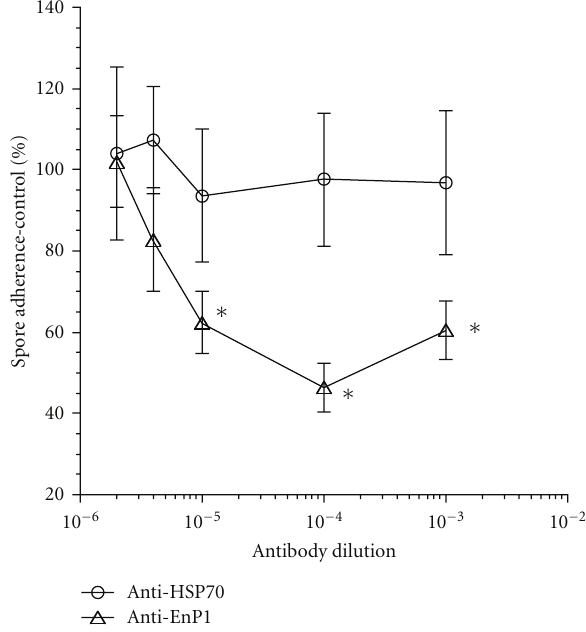
Figure 3: Purified antibodies specific for the internal C1 Hsp70 protein does not inhibit E. cuniculi spore adherence to rabbit kidney host cells. Increasing concentrations of C1 antibodies (open circles) or EnP1 specific antibodies (open triangle) were incubated with spores in the presence of confluent host cells. Control samples excluded antibodies. After 4-hours, unbound spores were removed by washing and the bound spores were quantified by immunofluorescence assay. Each antibody dilution sample was performed in triplicate. Statistical significance is indicated with asterisks ( P < .